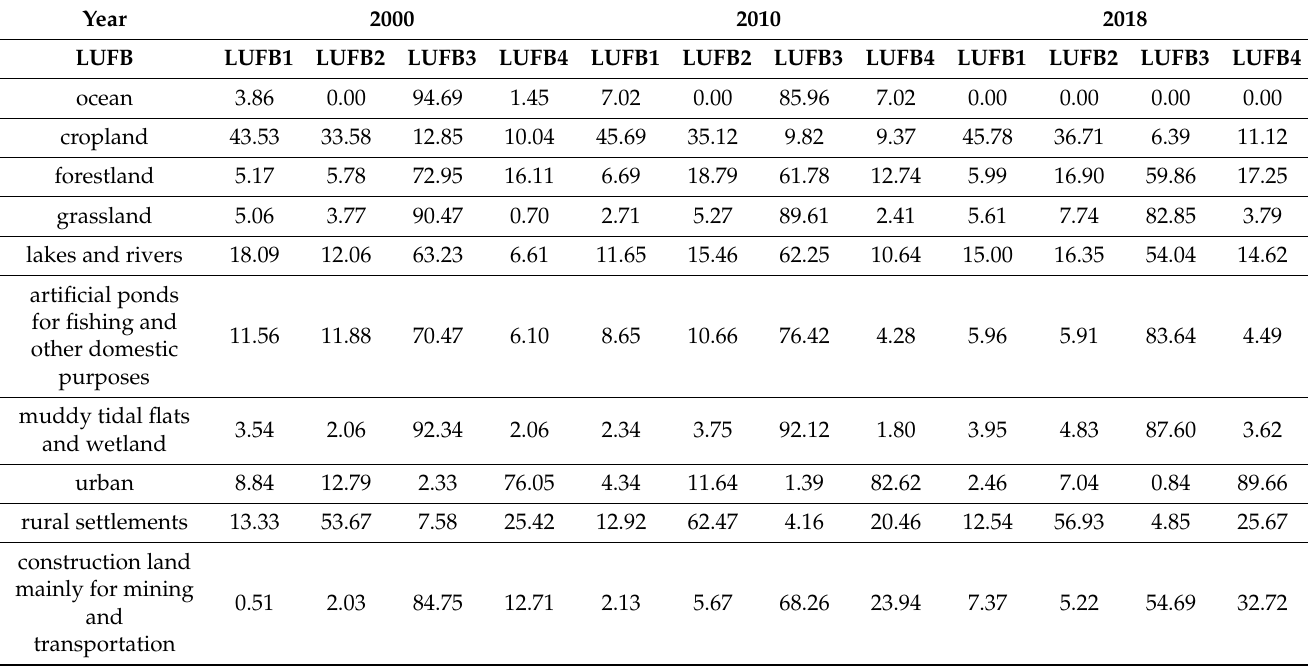
Table 3. Percent of land use structure (% of total) for each bundle: 2000, 2010, and